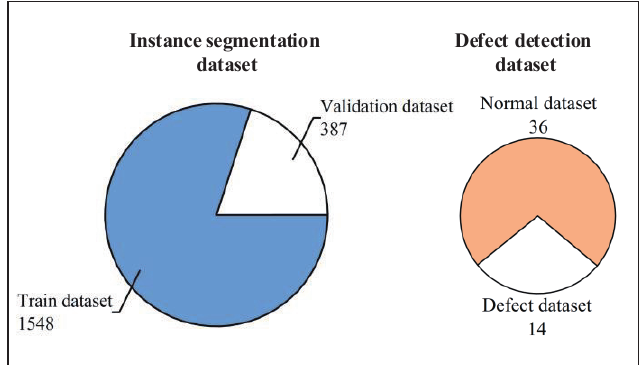
Figure 4. Dataset composition of the substation equipment infrared